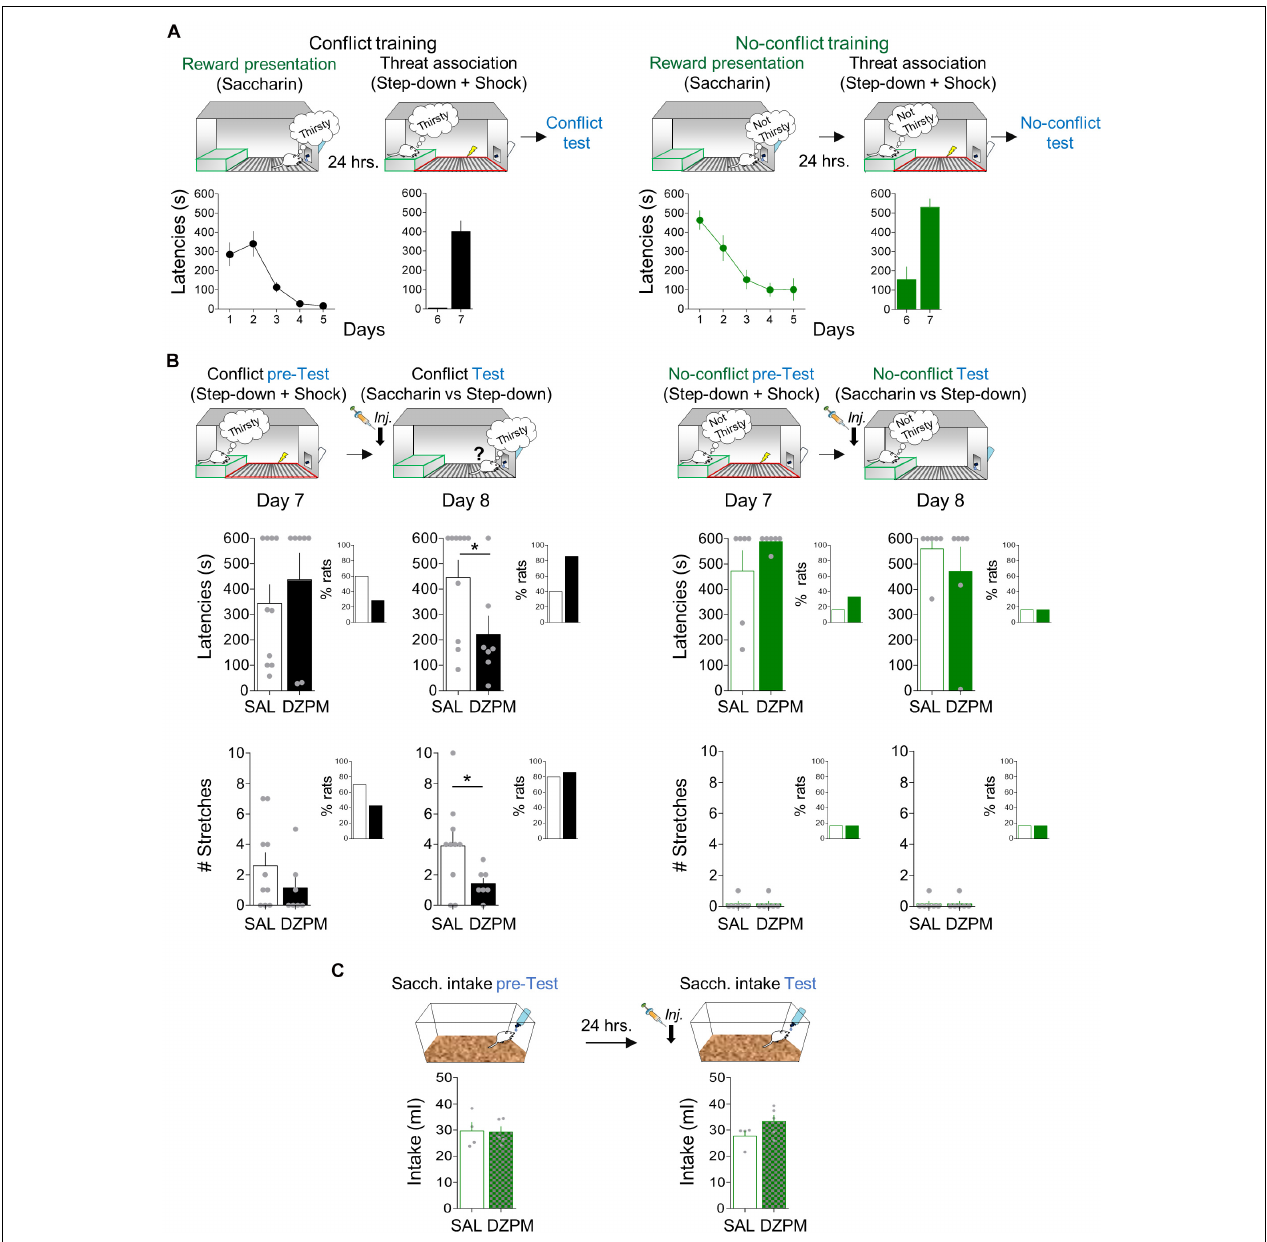
FIGURE 3 | Diazepam decreases step-down latencies and stretched postures during the conflict test without affecting no-conflict conditions. (A) Rats acquired step-down avoidance either mediated by conflict or no-conflict. Left , In the conflict condition (black), rats ( n = 17) innately motivated to drink (thirsty) step down from the platform (safe zone, green) to obtain sweetened water (saccharin; reward presentation) from the bottle at the end of the grid, followed by learning that the act of stepping down was associated with the occurrence of a mild footshock in the grid context (threat zone, red). Right , In the no-conflict condition (green), rats ( n = 12) with free access to water (not thirsty) stepped down the platform to obtain saccharin solution, followed by learning that stepping down was associated with footshock delivery in the grid. Time to step down with four paws onto the grid (latency in seconds) is presented by a single trial per day. By the end of the training, both groups showed high latencies to step down. (B) Before injection (pre-test), SAL and DZPM groups, in both conflict ( left , black) and no-conflict ( right , green) conditions, showed high latencies to step down (top) and stretched postures (stretches, bottom) toward the reward site. The following day, after injection (test), DZPM-treated rats decreased step-down latencies (top) and the numbers of stretches (bottom) during the conflict condition ( n = 7) without affecting the no-conflict condition ( n = 6), as compared to the SAL-treated rats ( n = 10 and n = 6, respectively). The inset graphs show the percent of rats that successfully stepped down from the platform to approach the reward [latencies (top) and the rats that displayed stretches (bottom)] during both conflict and no-conflict conditions before (pre-test) and after (test) drug manipulation. (C) Rats in their home cages showed similar levels of saccharin intake before (pretest) and after (test) injection of SAL and DZPM (SAL, n = 4; DZPM, n = 5). Error bars indicate SEM. * p <